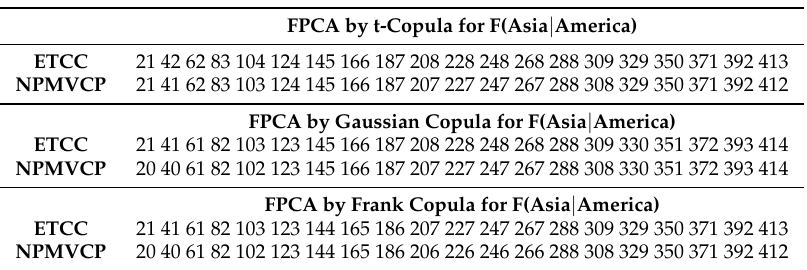
Table 23. Change point detection by ETCC and NPMVCP of FPCA and copulas with real exchange currency data of America (1/3/2013 to 10/3/2014) and Asia (1/4/2013 to 10/6/2014). FPCA by t-Copula for F(Asia |